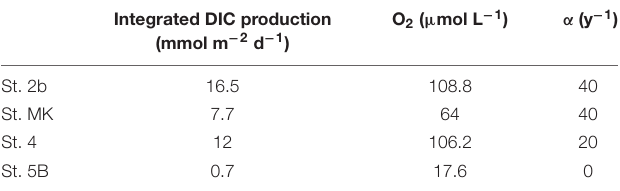
TABLE 3 | Integrated DIC production (in mmol m − 2 d − 1 ) for the station studied in